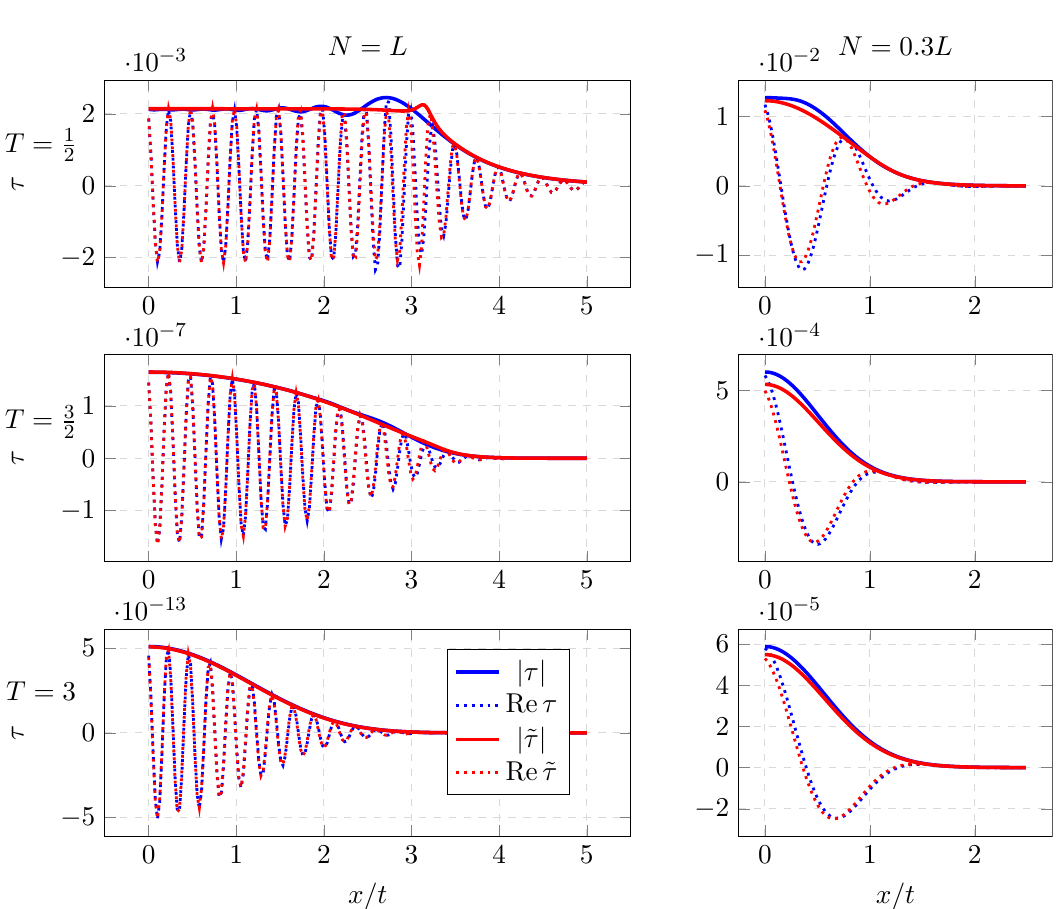
Figure 12: The Fredholm determinant τ -function from (62) and quasi- τ -function ˜ τ from (148) are plotted against speed x / t side by side. The dotted lines are the real part of these complex functions and the solid lines are their moduli. From top to bottom, at temperatures T ∈ { 0.5,1.5,3 } , from left to right we have densities N / L = 1 and N / L = 0.3. We use η ( k ) from (149). The time is t = 10, at higher times, the amplitude will be attenuated more. The distribution is Fermi-Dirac, (23), shift ν = 0.4. Finally, the unknown constant C from (147) is set to zero, which 0 ostensibly does not result in a large